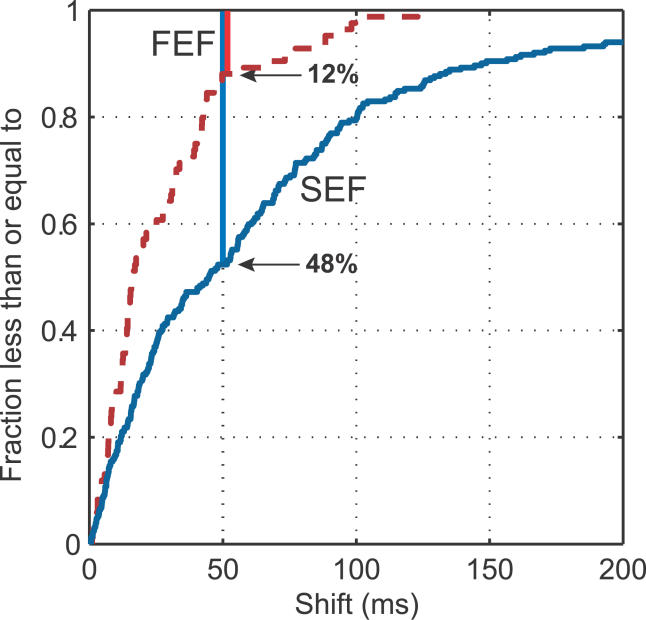
Comparison of FEF and SEF Shift MagnitudesLines, cumulative distributions of shift magnitudes for FEF (dashed line) and SEF (solid line) sites. FEF effects are significantly weaker (Kolmogorov-Smirnov statistic,
p > 10
−6); e.g., only 12% of FEF shifts are greater than or equal to 50 ms, while 48% of SEF shifts are.